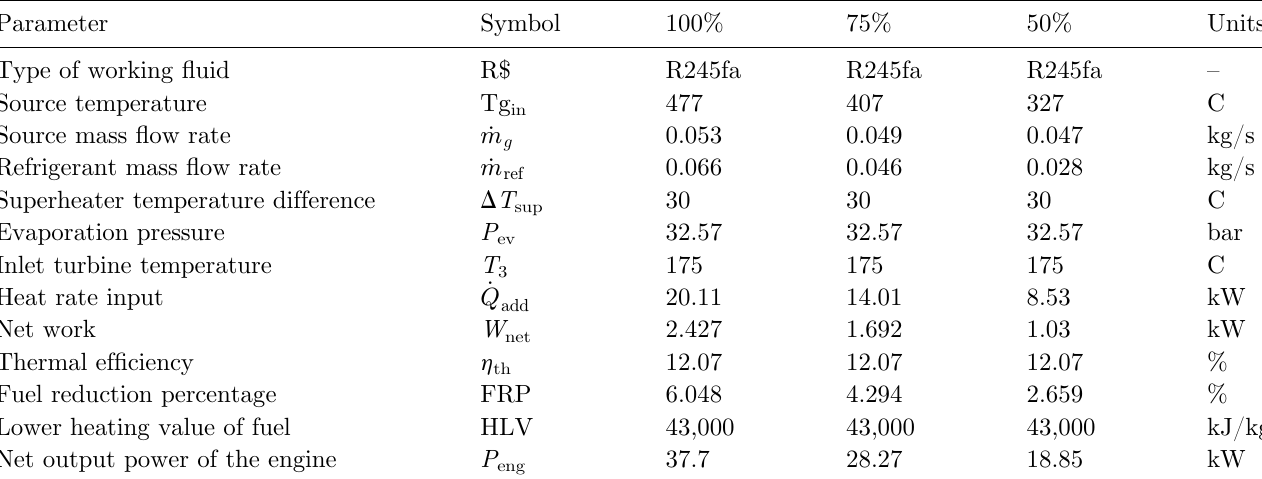
Table 2. Effect of load variations on ORC performance.